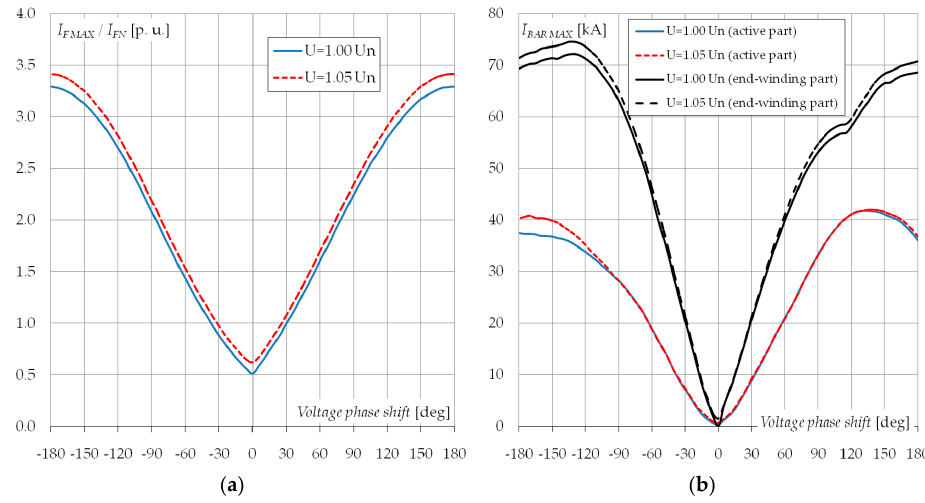
Figure 8. Maximum amplitude of field current ( a ) and rotor bar current ( b ).